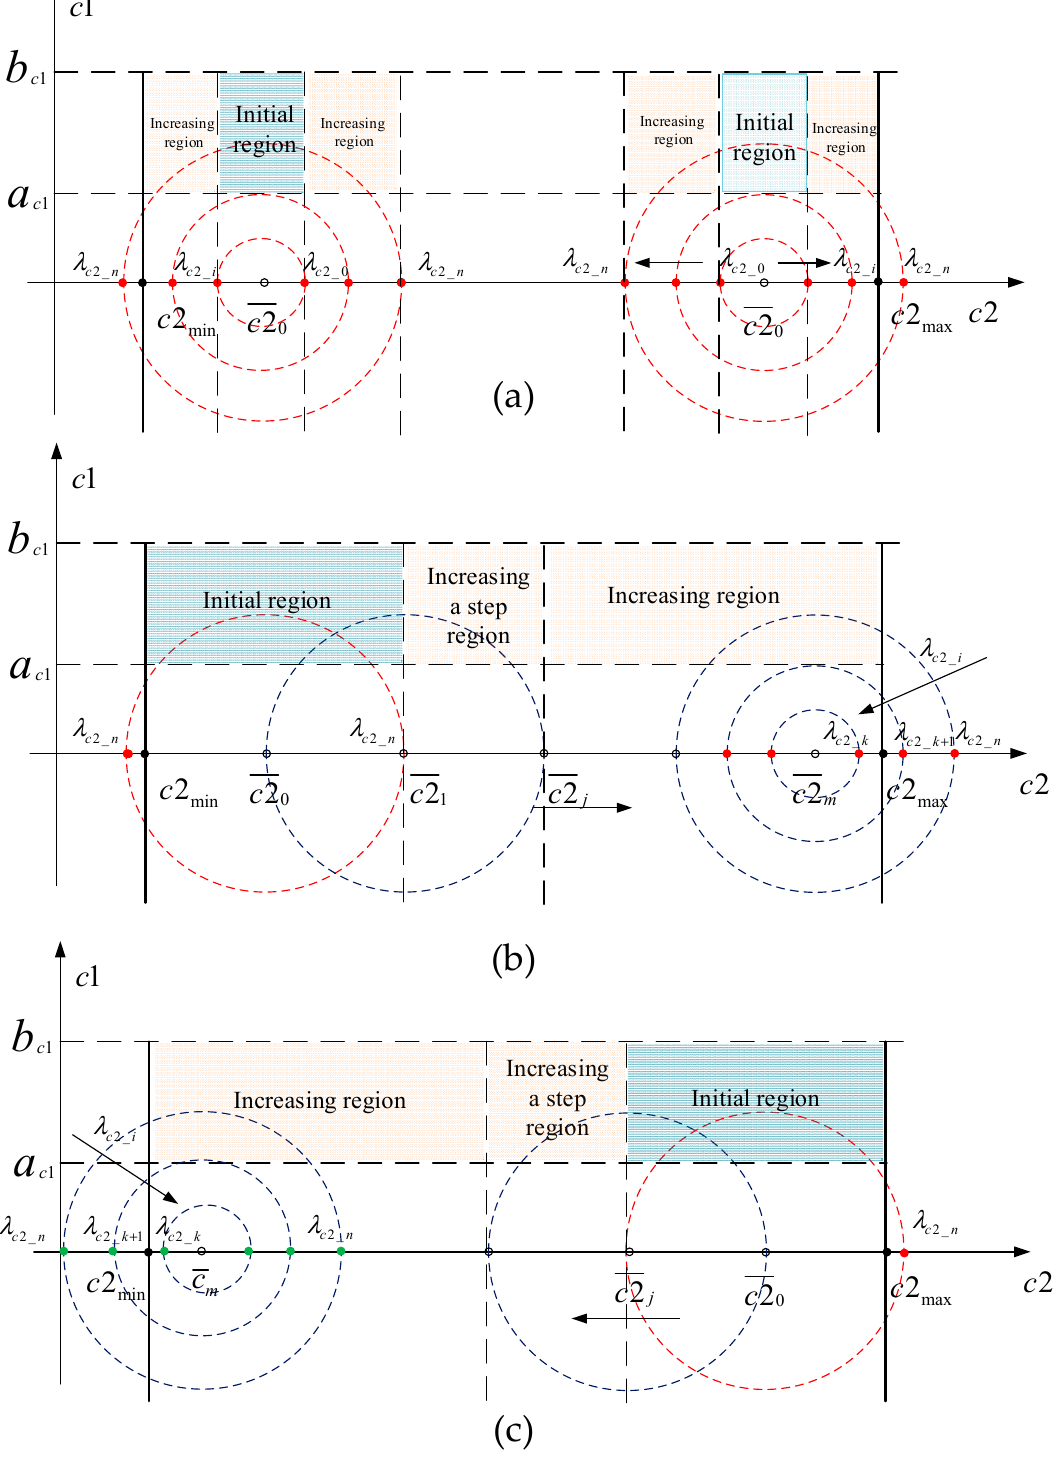
Figure 12. Process employed to search for the upper/lower bounds of uncertainty parameter c 2 when c 1 is in the range of [ a c 1 , b c 1 ] . ( a ) Finding a boundary for an uncertainty parameter and determining its type; ( b ) Searching for the lower bound; ( c ) Searching for the upper bound.